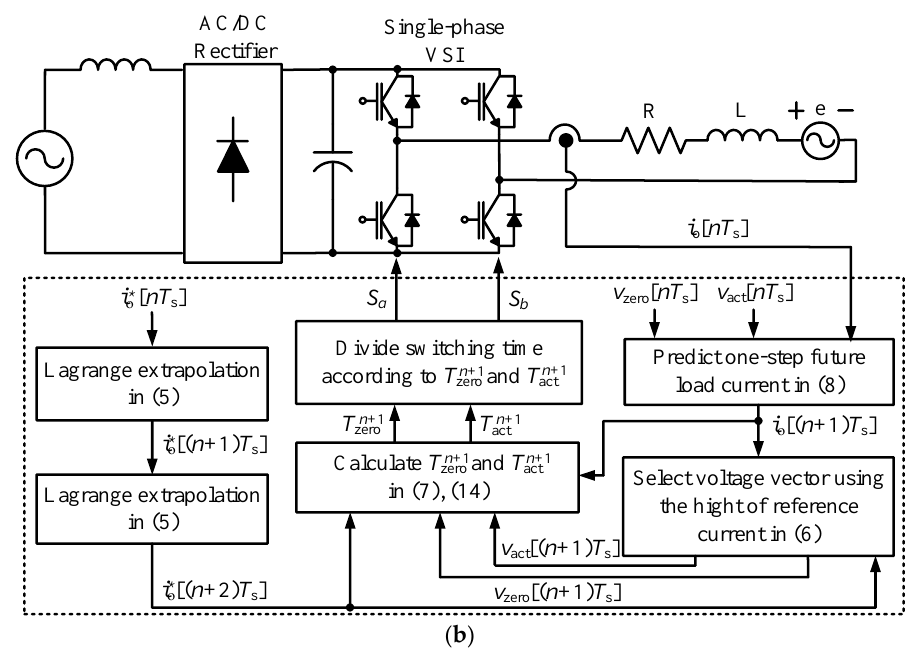
Figure 6. ( a ) Flowchart of the proposed method; ( b ) block diagram of the proposed method. Table 1. Comparison of conventional model predictive control (MPC) methods with constant switching frequency and proposed method.